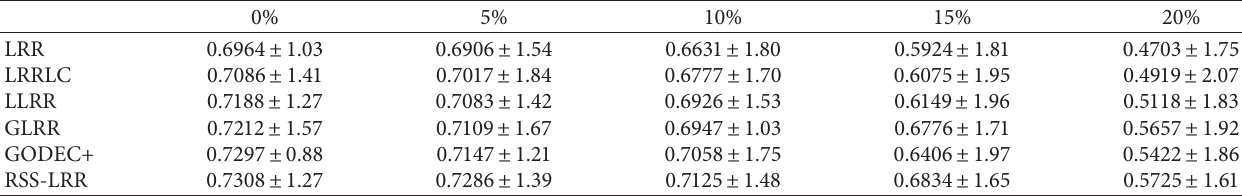
Table 3: Clustering results concerning the accuracy of different algorithms on the CMU PIE dataset.